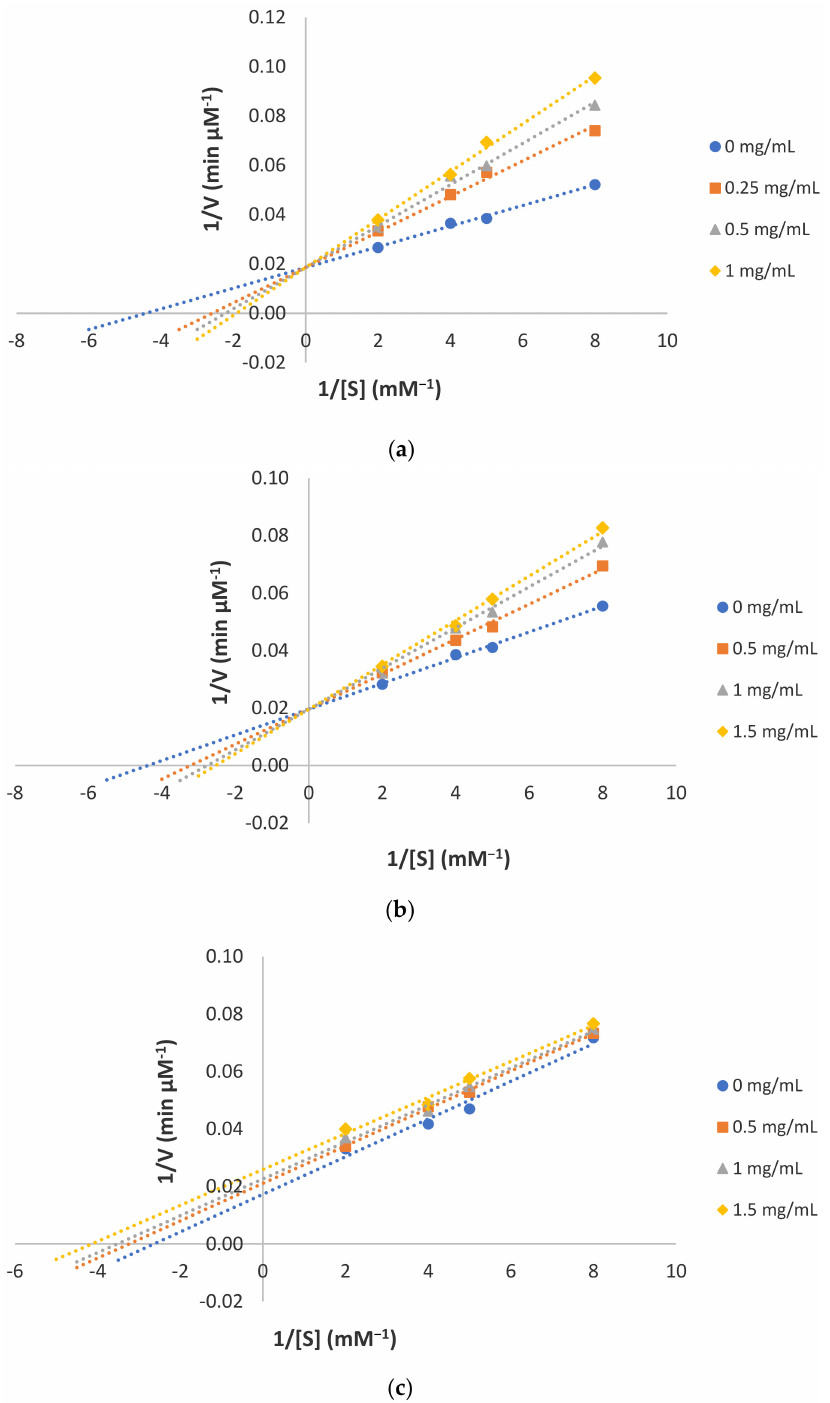
Figure 2. Lineweaver–Burk plot for the inhibition of diphenolase activity by ( a ) DIP1; ( b ) DIP2; and ( c )